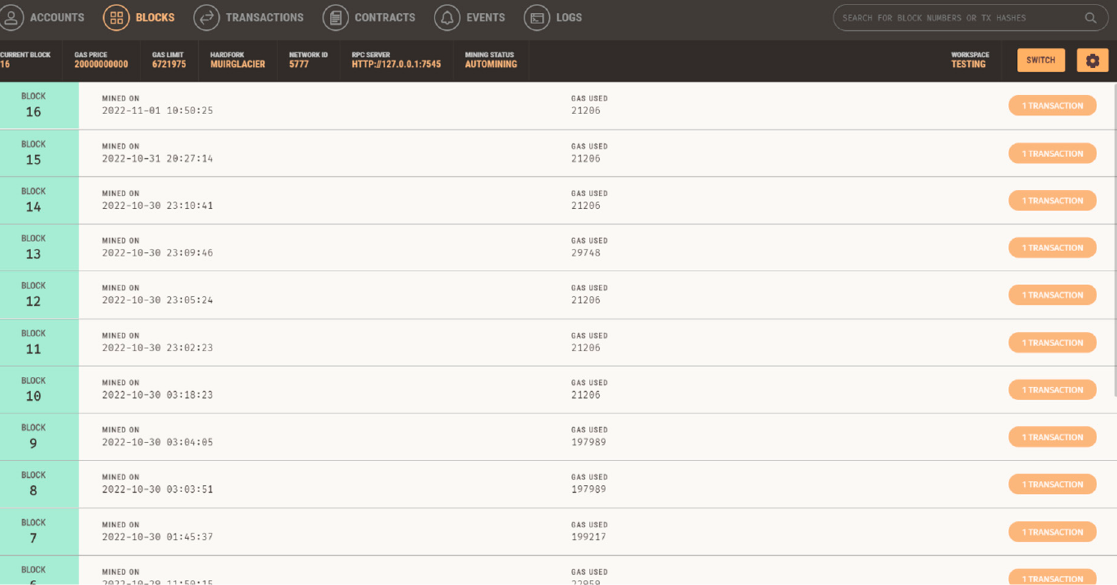
Figure 8. Details of block 16 on the Blockchain server. In Figure 9, only a few transactions per block might have negatively affected through- put. However, when there were 10 transactions per block, the throughput increased quickly and the performance boost started to decrease. With this network configuration, the maximum throughput of 350 tps resulted in approximately 100 transactions per block.